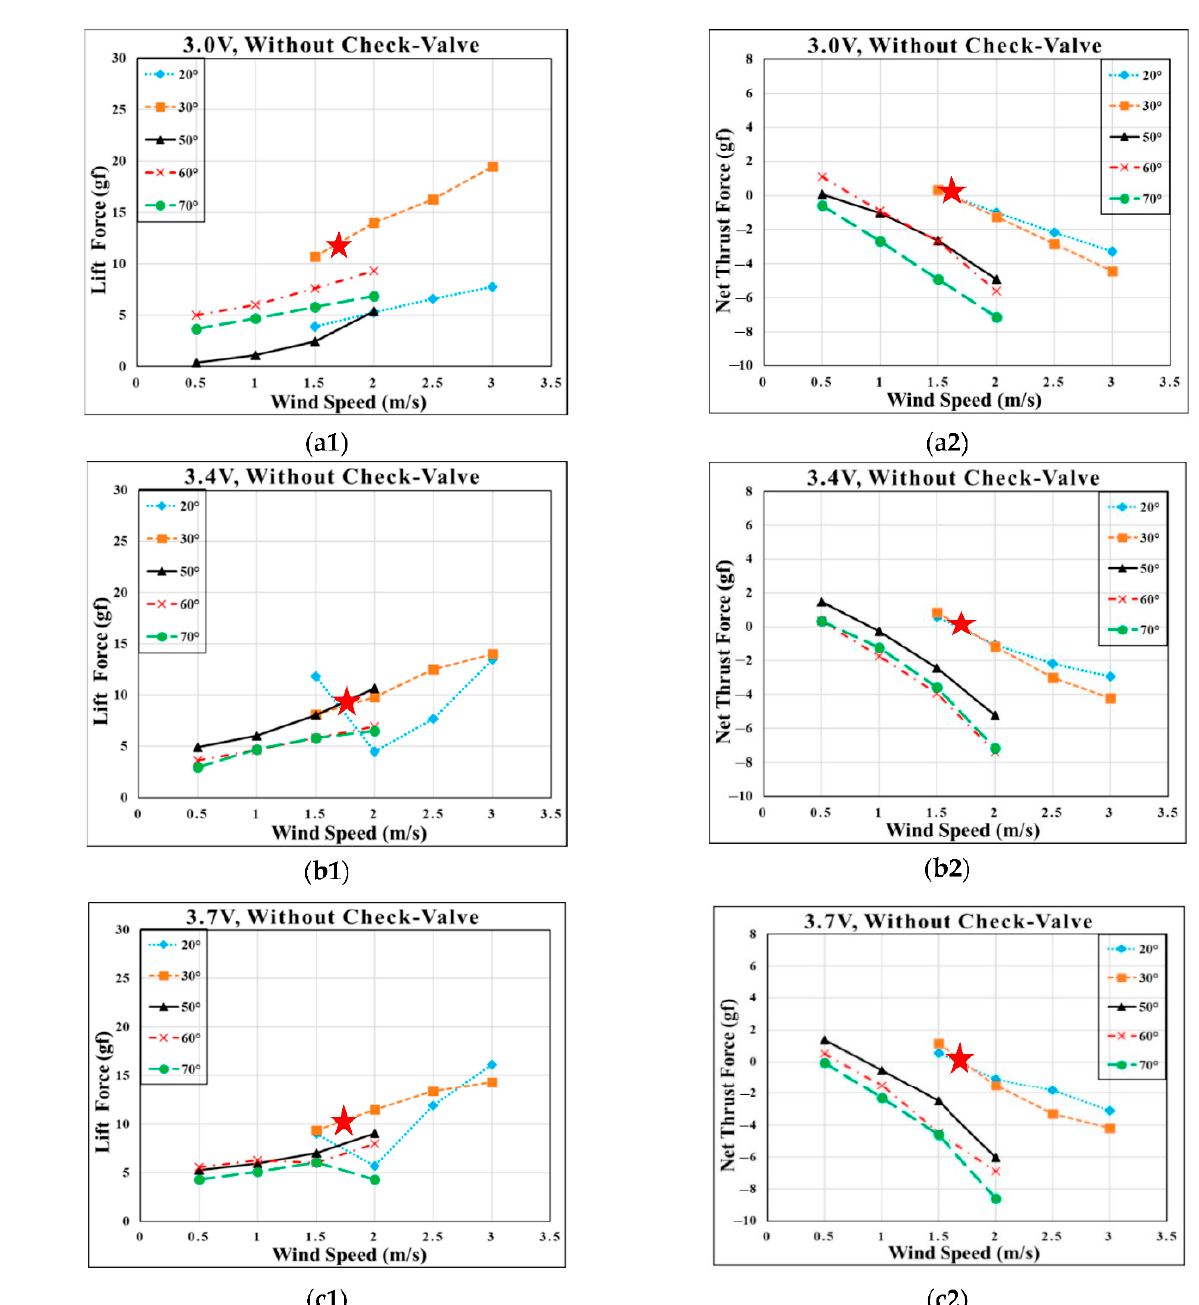
Figure 8. The lift and net thrust, subject to the wing without check-valves, for various driving voltages: ( a ) 3.0 V; ( b ) 3.4 8